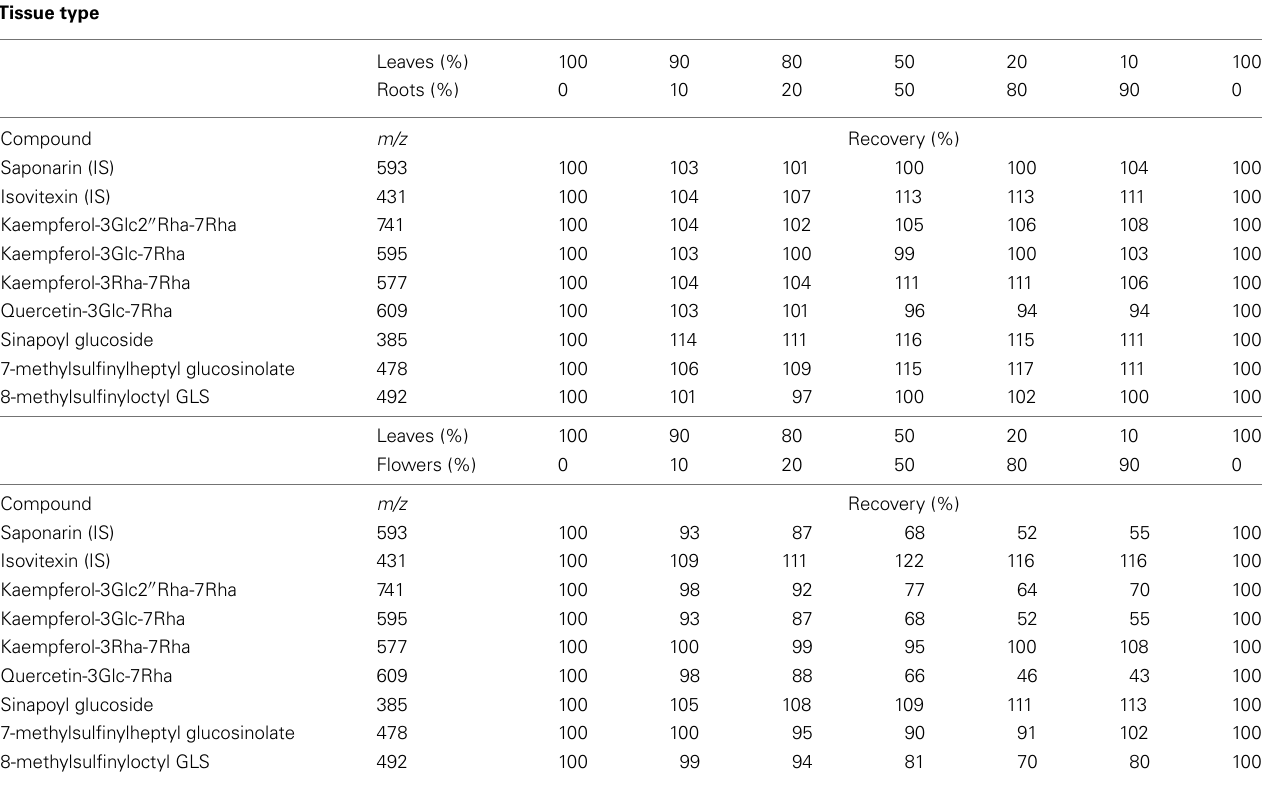
The peaks which were detected in leaves, roots, and flowers, were used for recovery test.The percentage recovery was estimated for evaluation using theoretical concentration of extracts mixture, [(level in leaves × A%) + (level in roots (or flowers) × B%)]/100], respectively.Three internal standard compounds, saponarin and isovitexin were used. Analysis was evaluated by three experimental replicates. (n = 3, SD of raw data <